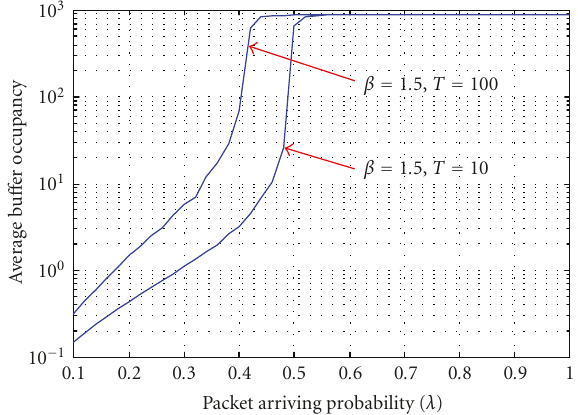
Figure 5: Average bu ff er size versus packet arriving probability ( β = 1 . 5).